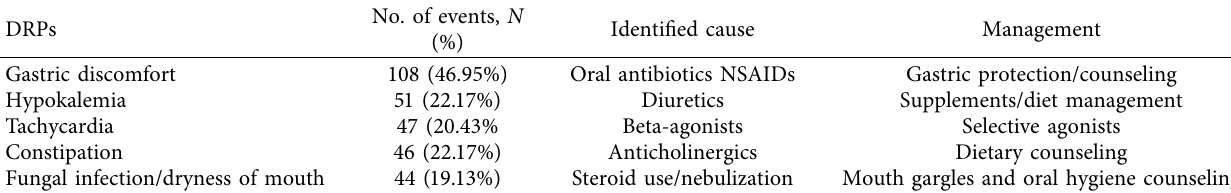
Table 5: Most common DRPs and their management during the study